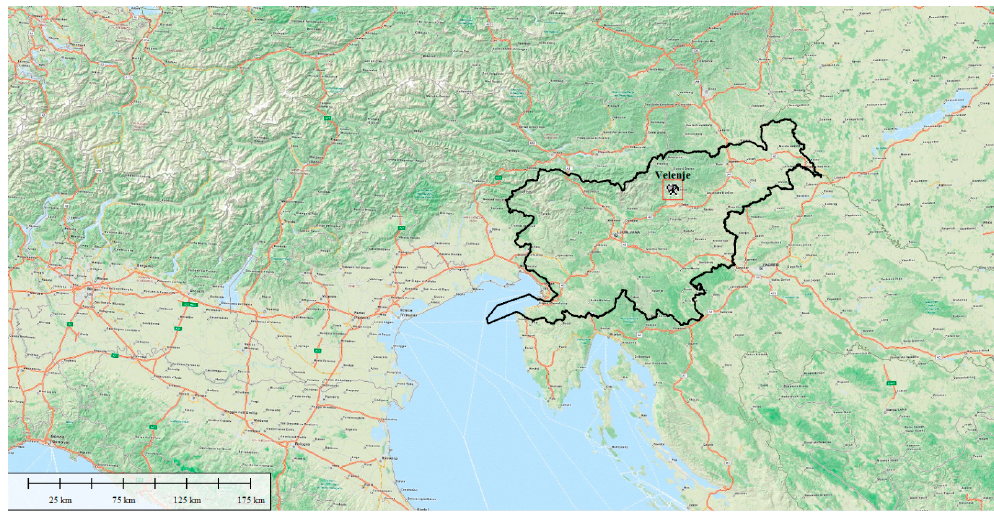
Figure 1. Location of the Velenje coal mine (VCM).